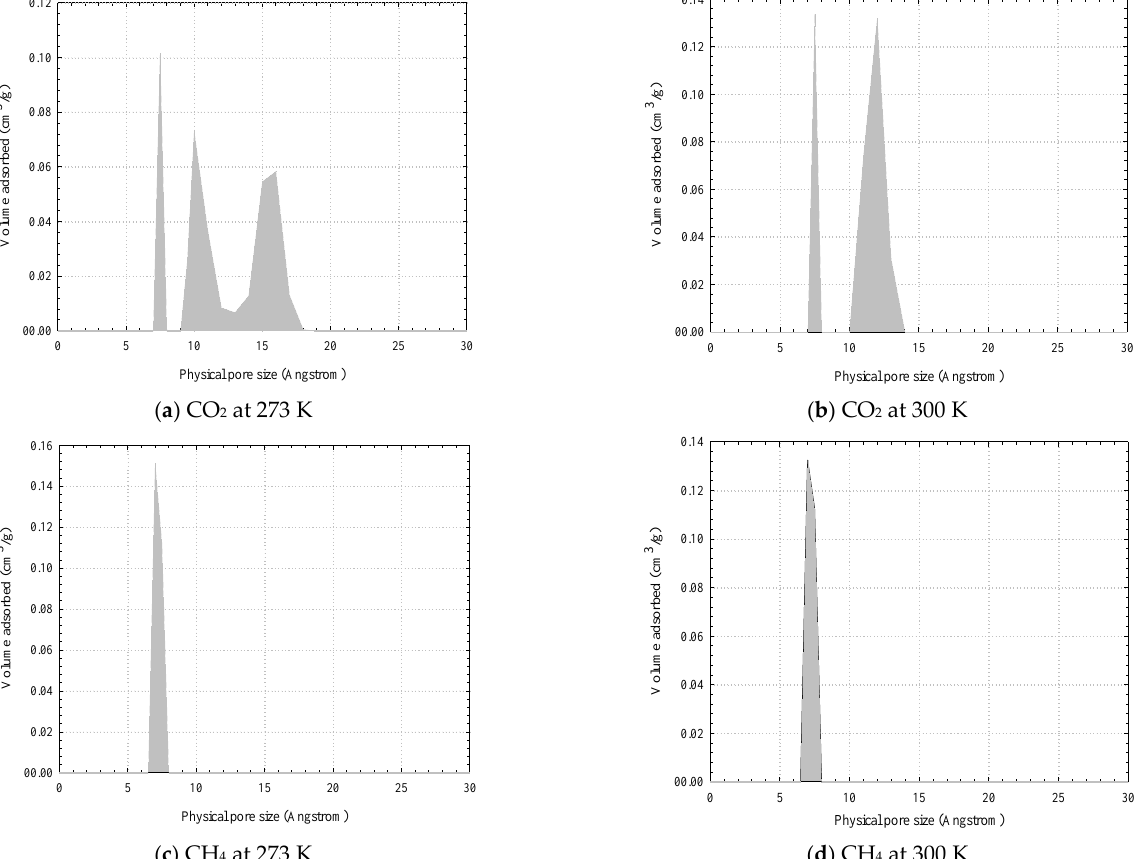
Figure 17. Pore size distribution obtained for LAC1 using the isotherms of CO 2 at 273 K ( a ), CO 2 at 300 K ( b ), CH 4 at 273 K ( c ) and CH 4 at 300 K ( d ).